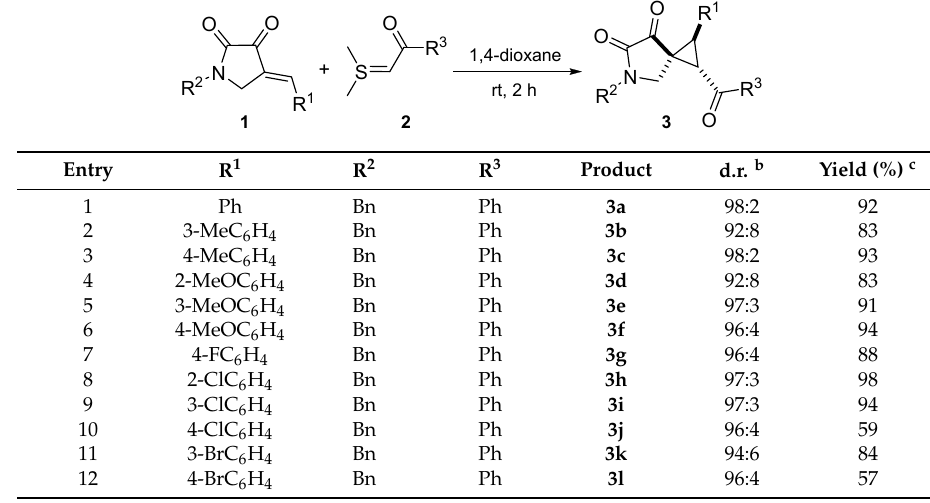
Table 2. Substrates scope of cyclopropanation of cyclic enones 1 with sulfur ylides 2 a .